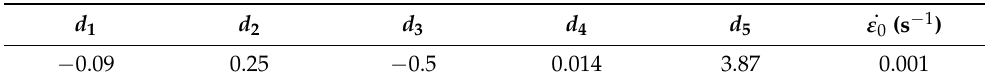
Table 2. Johnson-Cook damage parameters